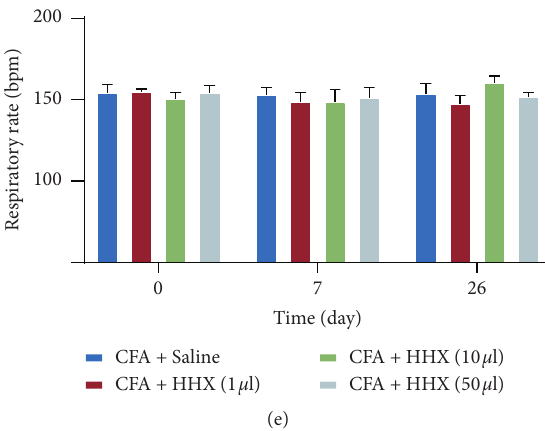
Figure 5: Bodyweight over time between groups ((a), (b), and (c)). There were no significant differences in the bodyweight after the treatment of HHX at doses of 1 μ l, 10 μ l, or 50 μ l (column factor, F (3, 16) � 0.4253, P � 0 . 7375; F (3, 16) � 1.077, P � 0 . 3870; F (3, 16) � 1.690, P � 0 . 2091). The effect of HHX on the respiratory rate ((d) and (e)). There were no significant differences in respiratory rate across the different saline subgroups or CFA subgroups (time × group interaction, F (6, 40) � 0.5040, P � 0 . 8016; F (6, 40) � 1.903, P � 0 . 1042).